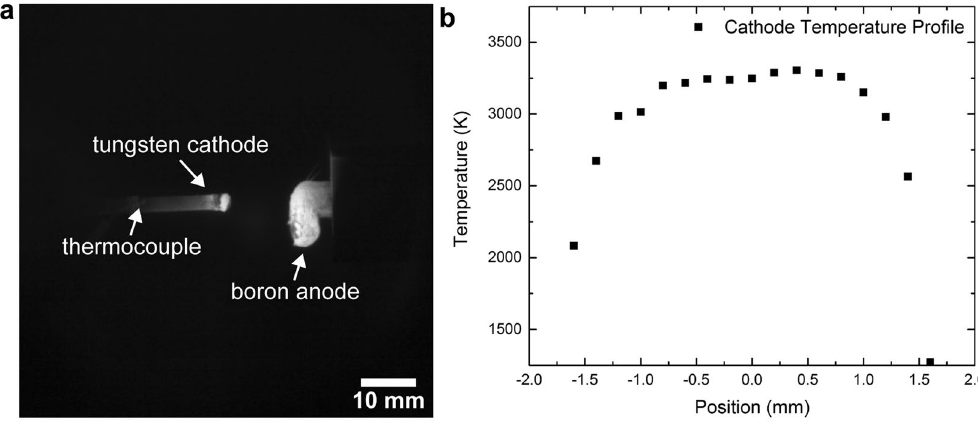
Figure 4. ( a ) IR image of the electrodes during the arc discharge. ( b ) Temperature profile of the plasma facing tungsten cathode tip. A position of zero corresponds to the center along the width of the electrode (3.2 mm dia.), with other relative positions toward the electrode edge